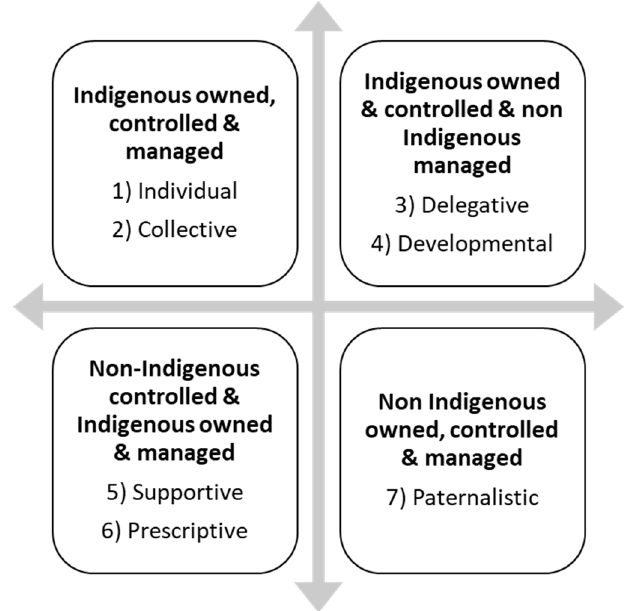
Figure 2. Models of Indigenous Social Enterprise based on degrees of Indigenous ownership, control and management.